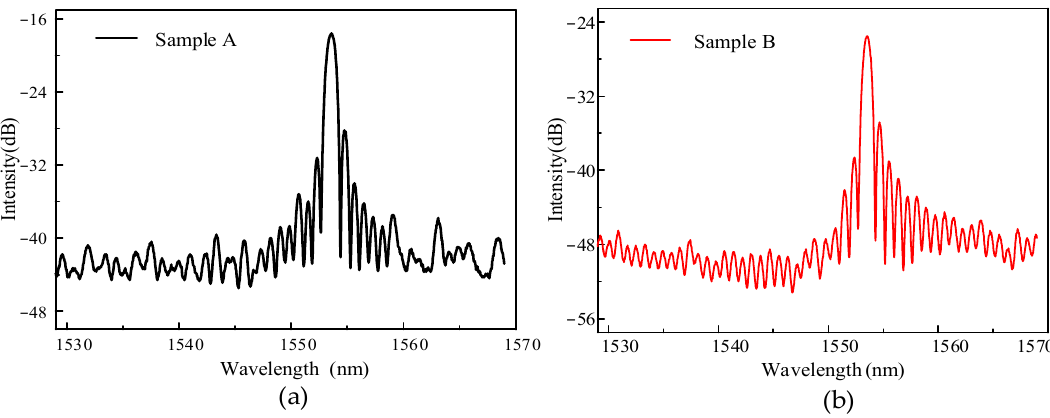
Figure 3. Reflection spectra of samples with different gratings. ( a ) Sample A; ( b ) Sample B.